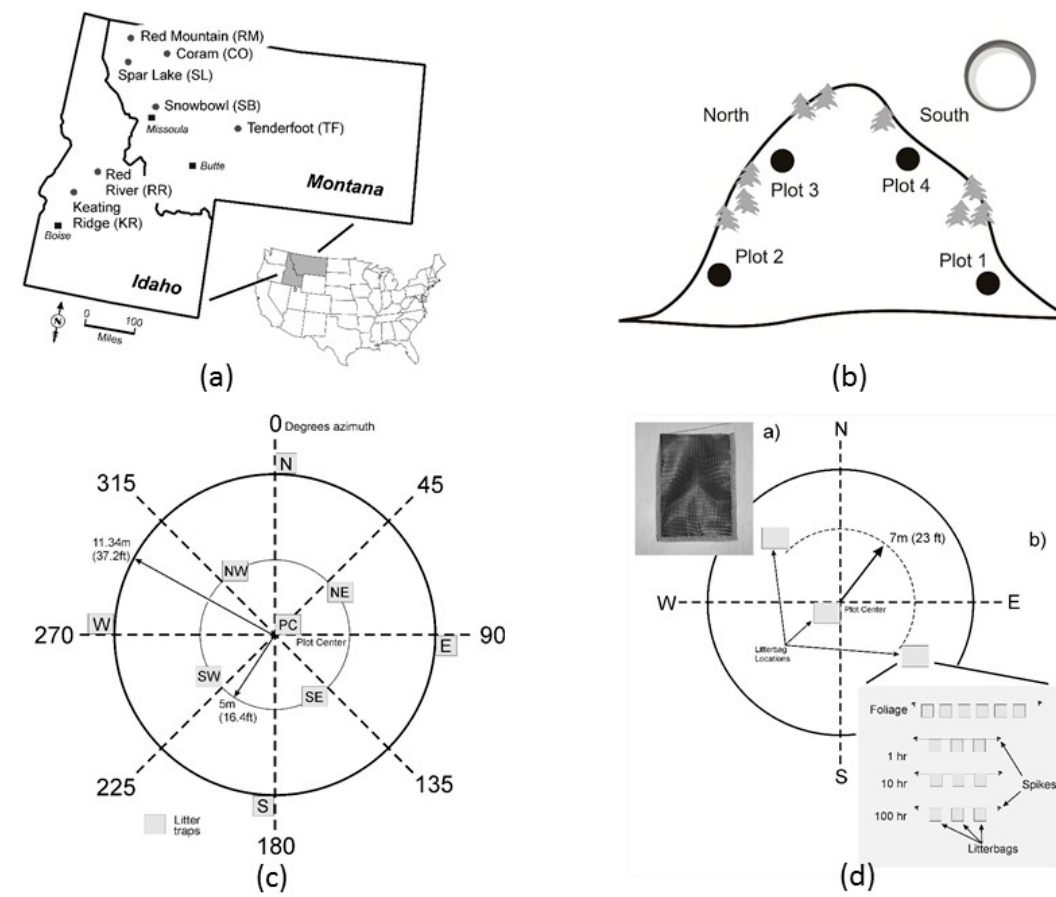
Figure 3. The sampling design of the FUELDYN study showing the ( a ) seven sampling sites; ( b ) the four plots per sampling site placed at high and low elevations and north and south aspects; ( c ) the littertrap placement within the 400 m 2 plot; and ( d ) the decomposition bag placement on the 400 m 2 plot.